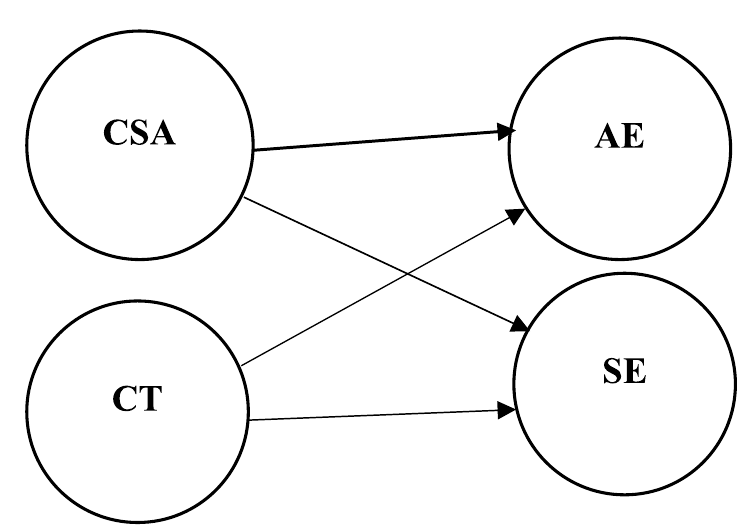
Fig. 1 Theoretical structural equation